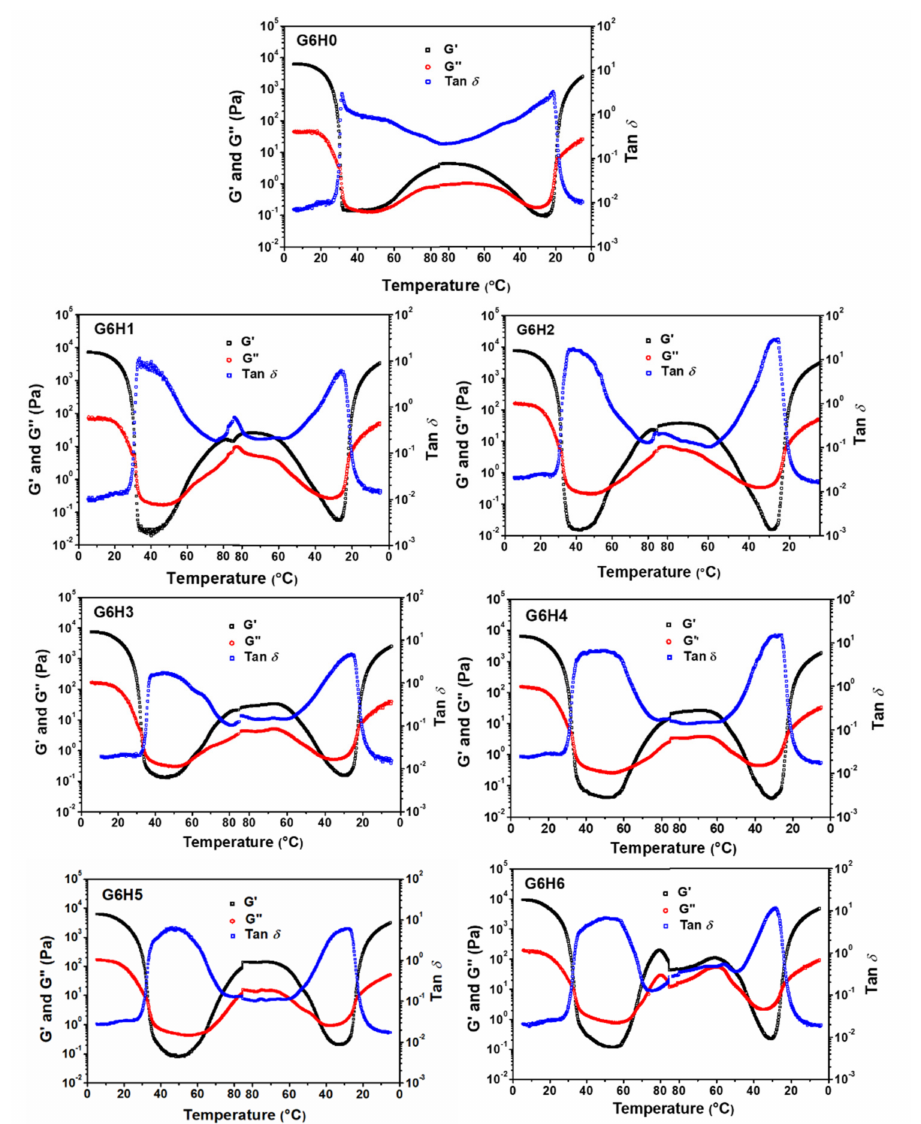
Figure 5. Variation of storage modulus (G (cid:48) ), loss modulus (G (cid:48)(cid:48) ), and tan δ as a function of temperature for solutions of GA and GA/HPMC